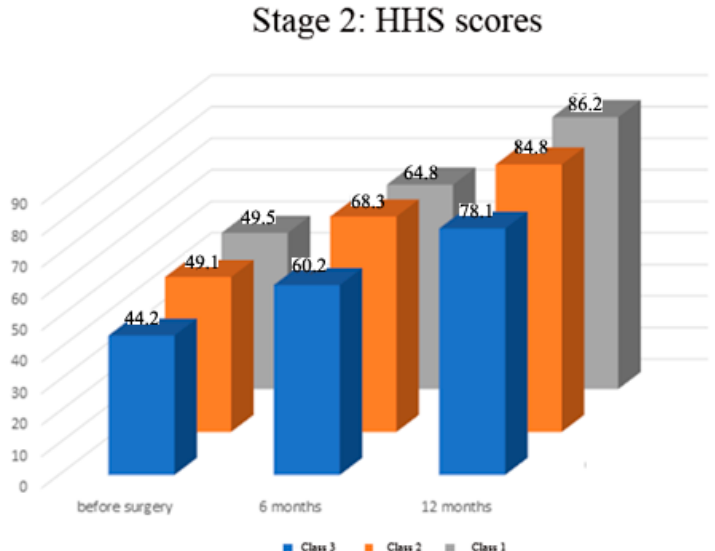
Figure 4. Stage 2—Dynamics of functional results by Harris hip score (HHS) before and after surgery. Preoperatively in all the examined patients, there was no significant difference in physical functioning and mental health scores according to the SF—36 scale (range of mean values of 11.8–13.4 and 6.8–8.1 respectively, p > 0.05, Figure 5). In all the examined patients, there was a significant increase in physical functioning and mental health scores according to the SF—36 scale (in the range of 51–52% in physical functioning, p < 0.001; and in the range of 70–78% in the scores of the mental health component p < 0.0001; Figure 6). The Class 1 patient group exhibited statistically significantly better result dynamics in the physical constituent of health after a year following the surgery than the Class 3 patients (mean 27.3 score ± 0.3 SEM vs. 24.5 ± 0.5 SEM, р < 0.05, Figure 6). There was no significant difference in the SF-36 functional scores among Class 1 and Class 2 patients ( p > 0.05, Figure 6). There was no significant difference in the mental health component of the SF- 36 scale in Class 2 and 3 patients ( p > 0.05), but these scores were significantly lower in comparison to Class 1 ( p < 0.05, Figure 6).